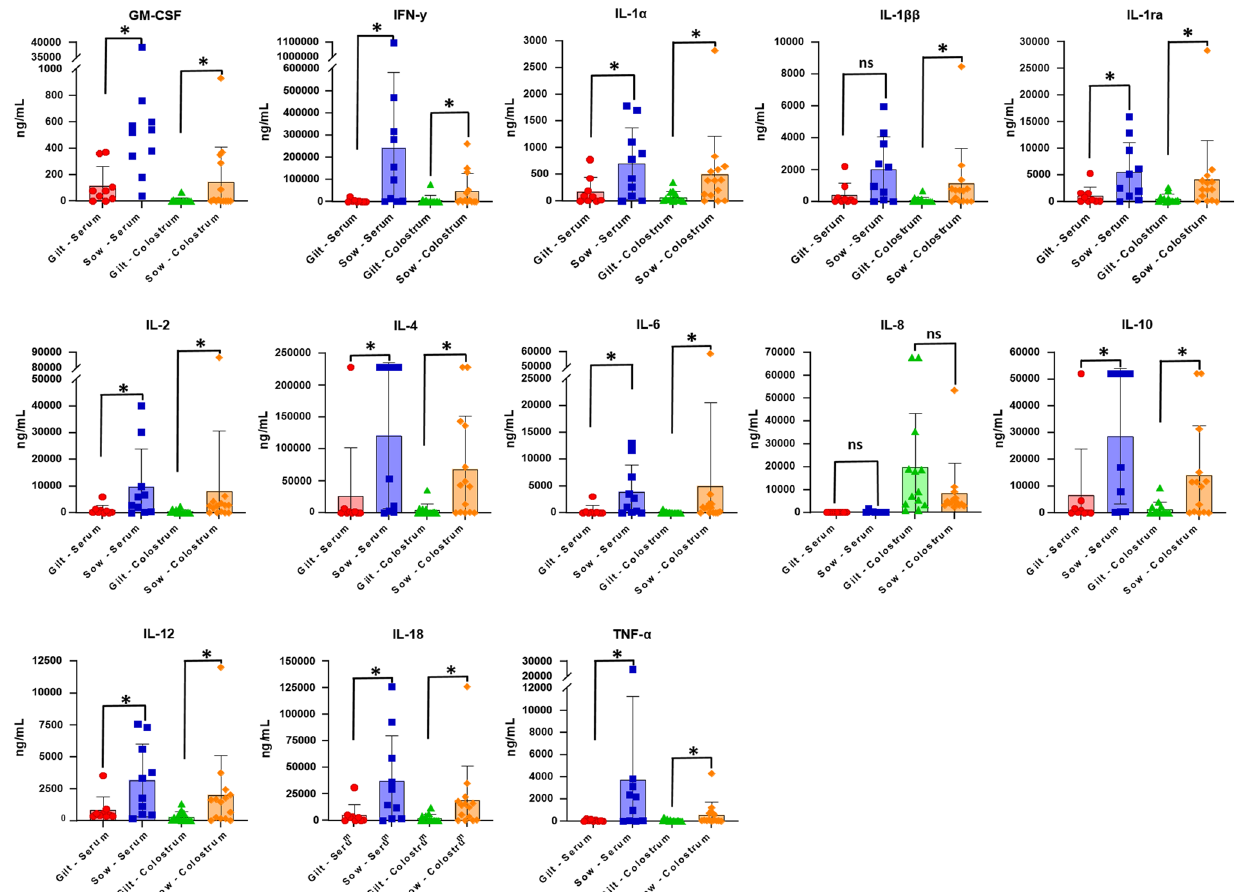
Figure 3. Comparison of cytokine concentrations (ng/mL) in colostrum and serum from gilts and sows in the first 3 h after farrowing. Error bars represent the standard error of the mean (± SEM). Different superscripts indicate significant differences among groups ( P ≤